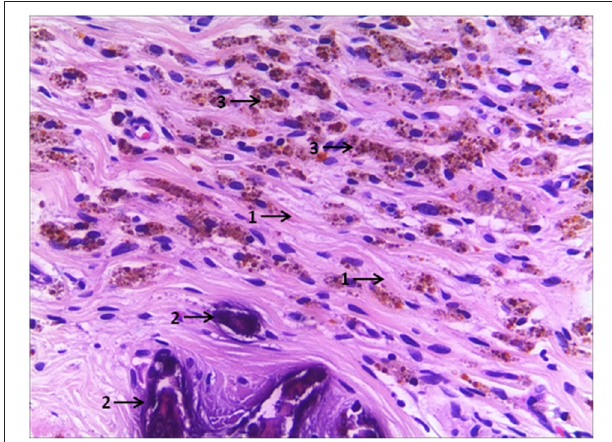
FIGURE 1 | A case of vanishing testis showing fibrosis (arrow 1), dystrophic calcifications (arrow 2), and hemosiderin deposits (arrow 3) in H&E stain. Images under × 200 visual field.